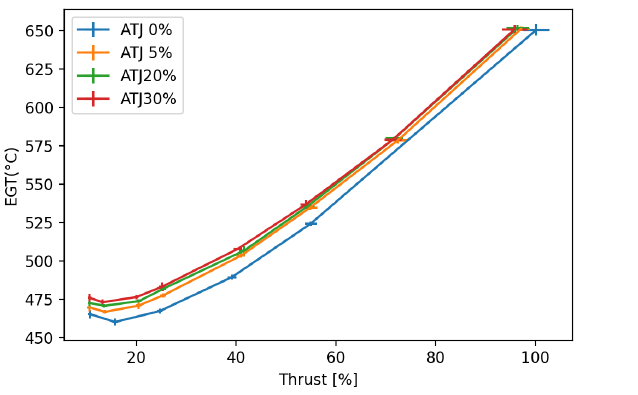
Figure 27. DGEN 380/ATJ: EGT.